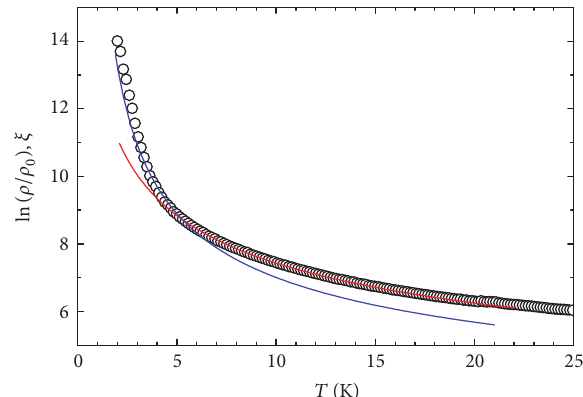
Figure 8: Experimental (symbols) ln [𝜌(𝑇)/𝜌 0 ] and calculated (lines) according to (10) 𝜉(𝑇) dependencies. Red and blue lines correspond to 𝑛 = 0 and 15,